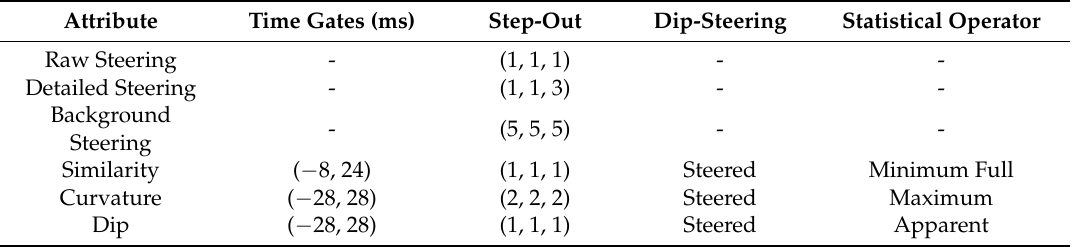
Table 1. Seismic attributes parameter